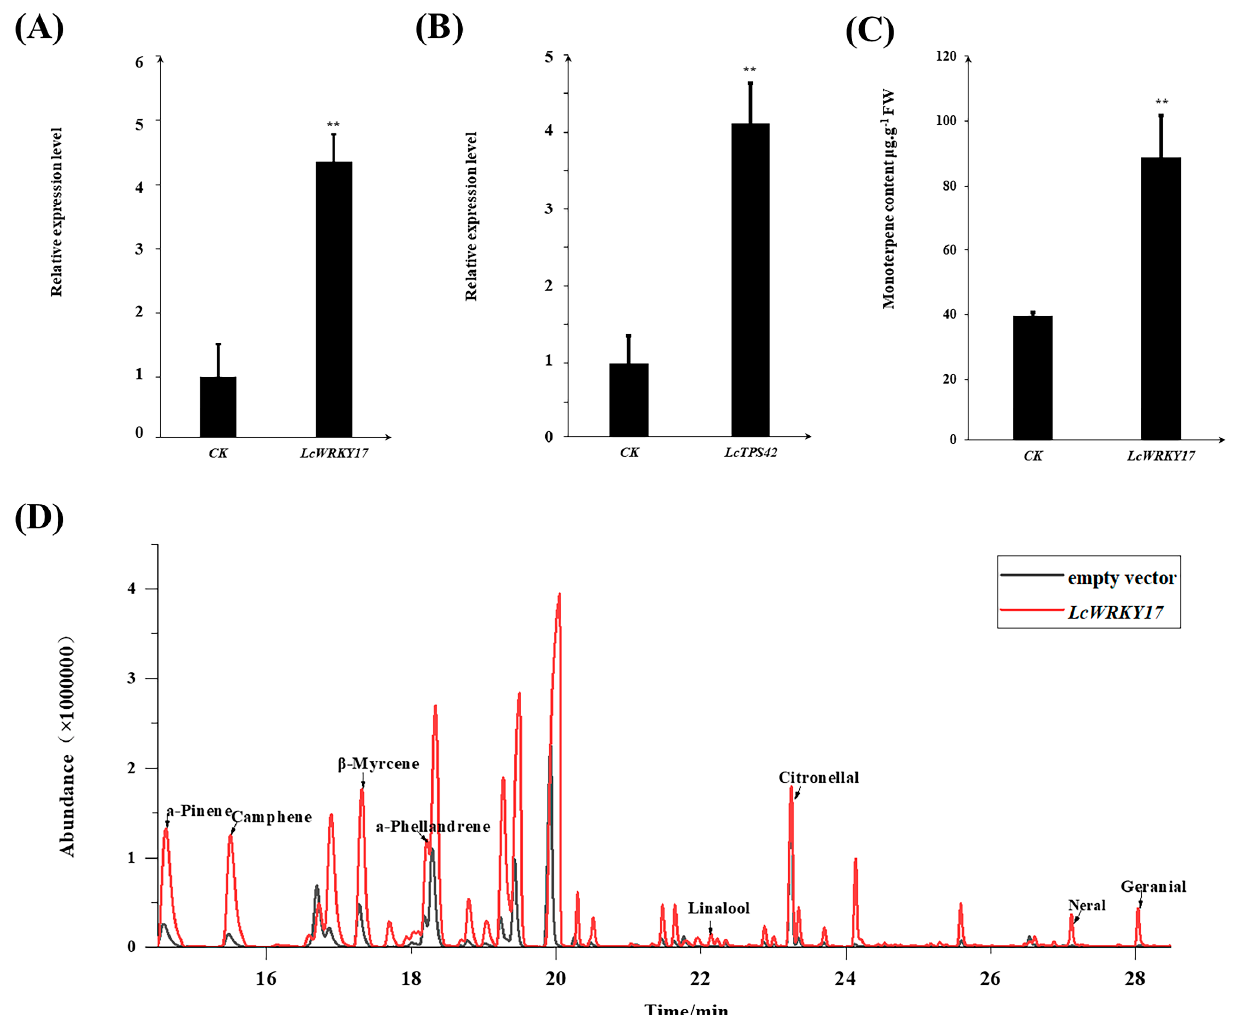
Figure 5. ( A ) Relative expression of LcWRKY17 in transient overexpression in L. cubeba . ( B ) Relative expression of TPS42 in transient overexpression in L. cubeba . ( C ) Monoterpene contents in leaves of L. cubeba after transient overexpression of LcWRKY17 . ( D ) Volatile components in leaves of L. cubeba with transient overexpression of LcWRKY17 . Data represent the mean ± SDs of three biological replicates. Student’s t -test was used to assess con fi dence levels (CK = blank control) (**, p < 0.01).